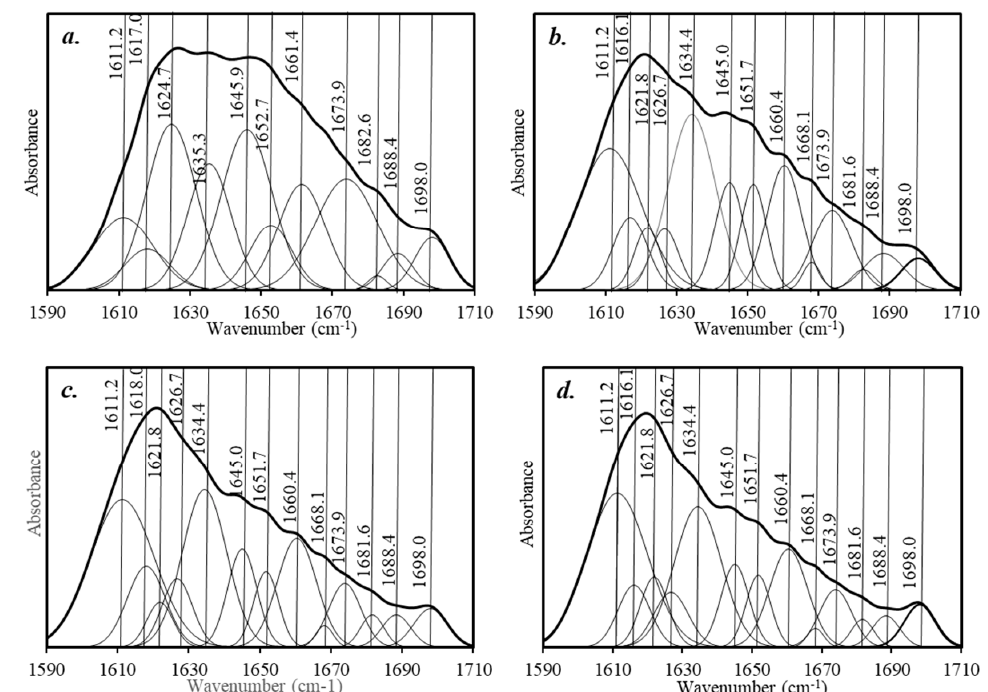
Figure 8. The ATR-FTIR spectra and the curve fitting of the ATR-FTIR spectra to determine the secondary of amide I: ( a ) the RS powder, ( b ) the original RS resin, ( c ) the RS hot-rolled resin without the boiling treatment, ( d ) the RS hot-rolled resin with the boiling treatment. Table 5. The secondary structure content (%) of amide I of RS powder, original RS resin, and the RS hot-rolled resin without and with boiling treatment.